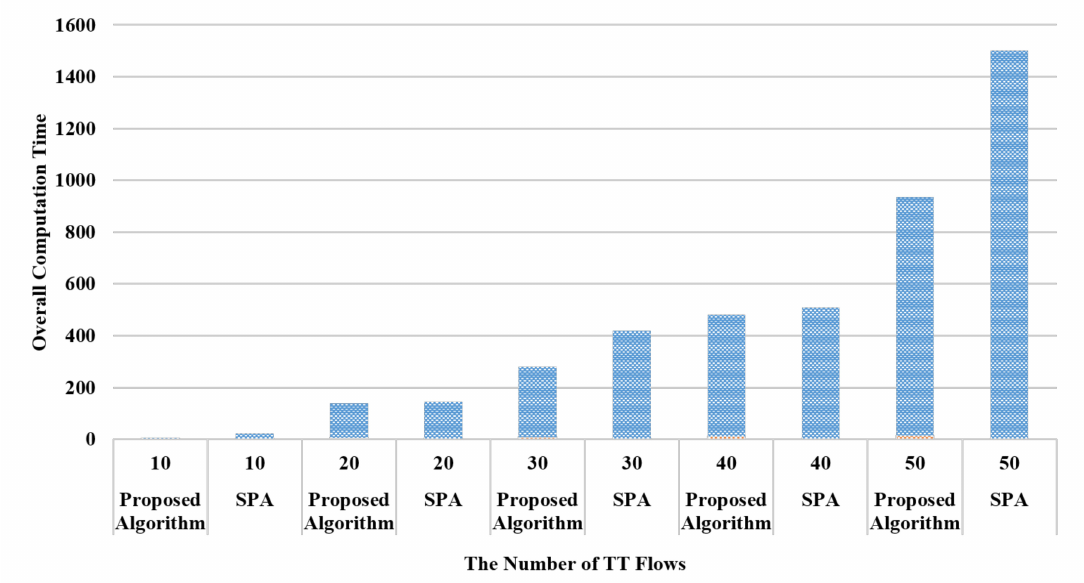
Figure 12. The overall computation time including routing and scheduling.